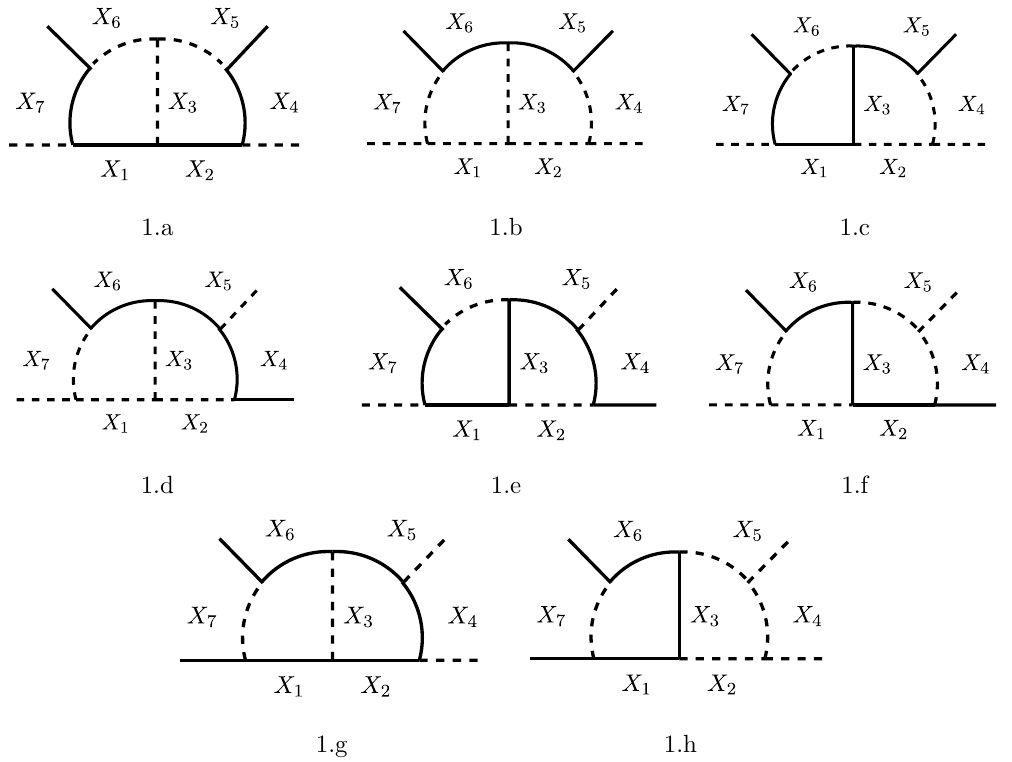
Figure 1. Two-loop diagrams for Class 1.a{1.h in Category 1.